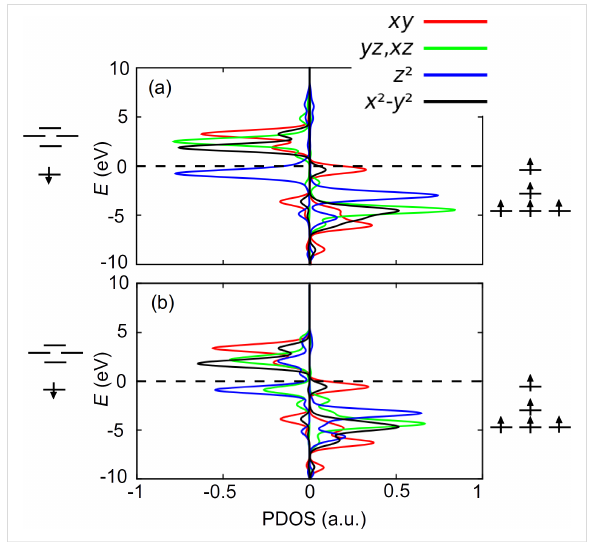
Figure 7: Spin-resolved PDOS on d-orbitals of the Fe atom of HS FeTPP (a) at the fcc site of Au(111) and (b) in the free